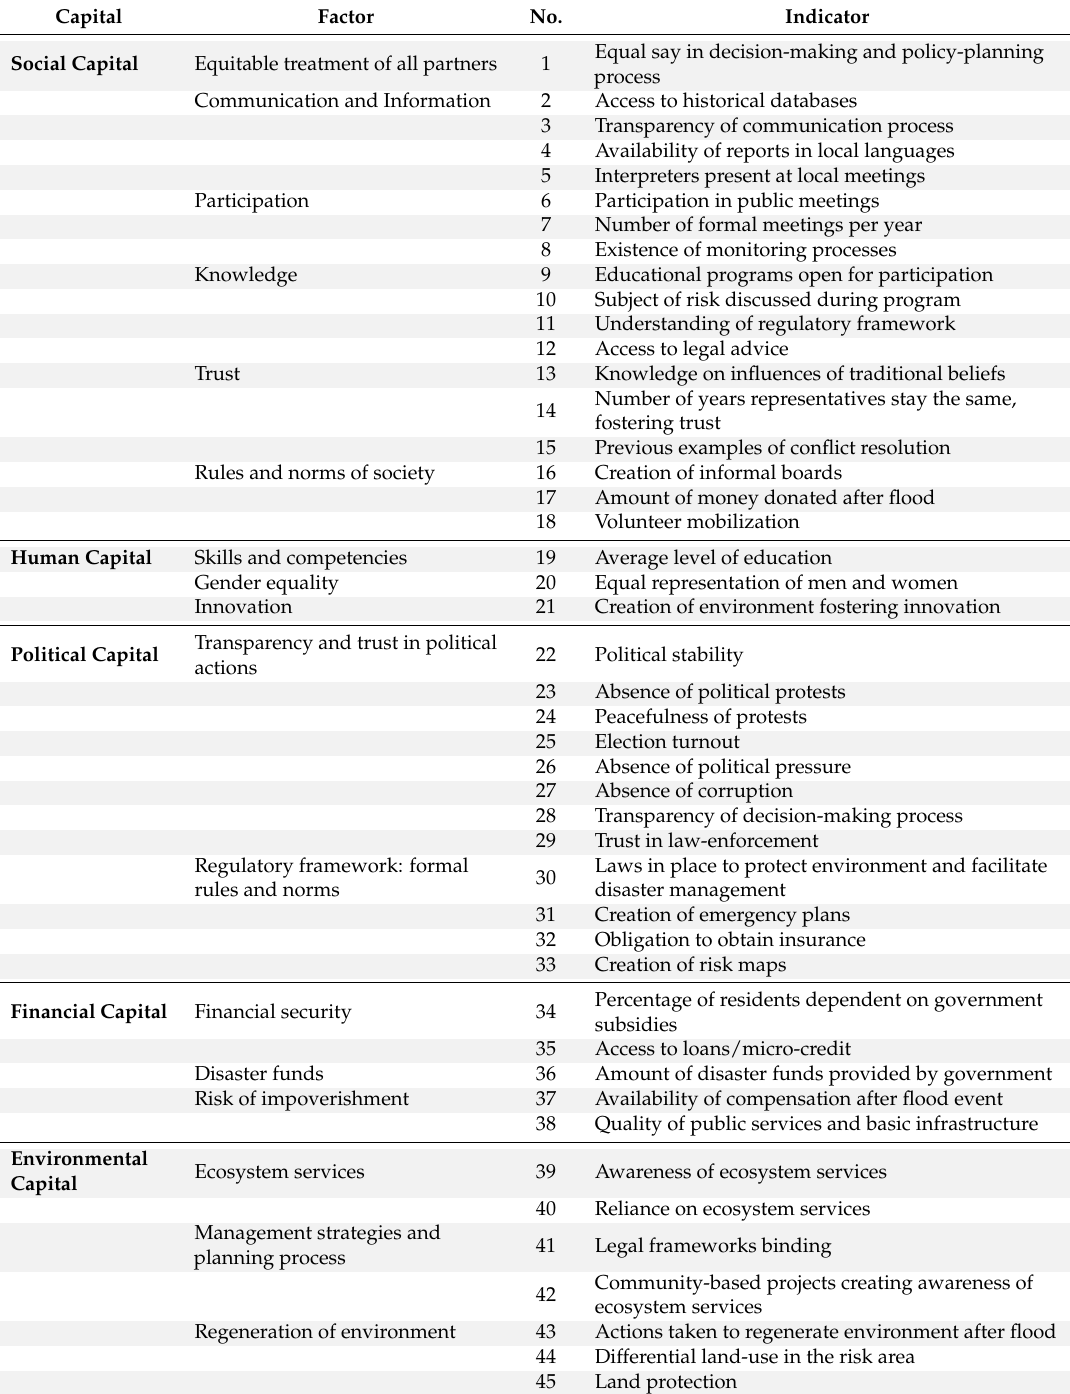
Table 1. List of capitals, factors and indicators forming part of the assessment of five capitals of local governance for water management in Quarry Road West informal settlement, Durban South Africa. Capital Factor No. Indicator Social Capital